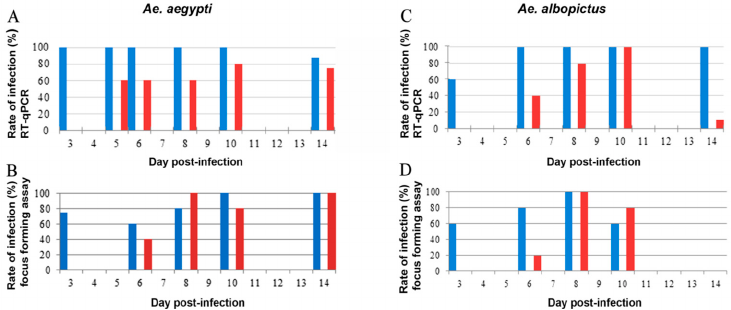
Figure 1. Rate of infection detected by RT-qPCR and immunochemical plaque assay in midguts (MG) and salivary glands (SG) of Ae. aegypti and Ae. albopictus. MG (blue bars) and SG (red bars) were analyzed by RT-qPCR ( A , C ) and titration ( B , D ) from Ae. aegypti ( A , B ) and Ae. albopictus ( C , D ). Ae. aegypti MG and SG were sampled on days 3, 5, 6, 8, 10, and 14, whereas Ae. albopictus MG and SG were sampled on days 3, 6, 8, 10, and 14. The graphs present the results of one experiment for which 5 mosquitoes were tested for each time point. It was repeated two